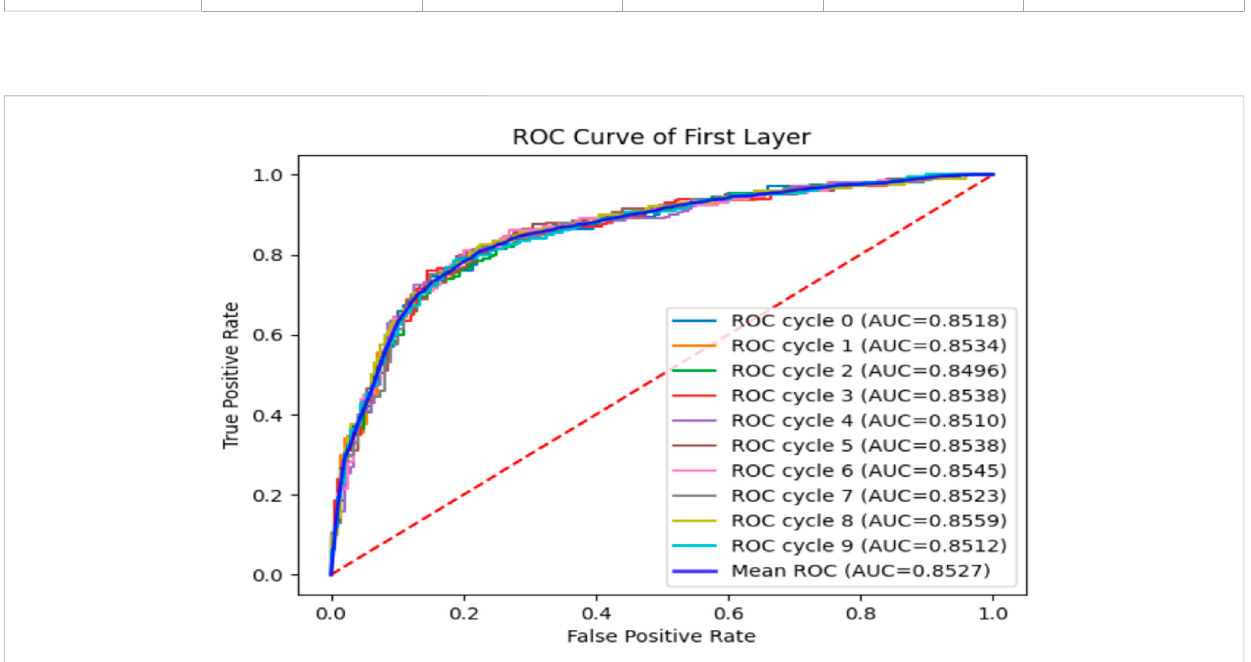
FIGURE 5 ROC curves for layer 1 (enhancer